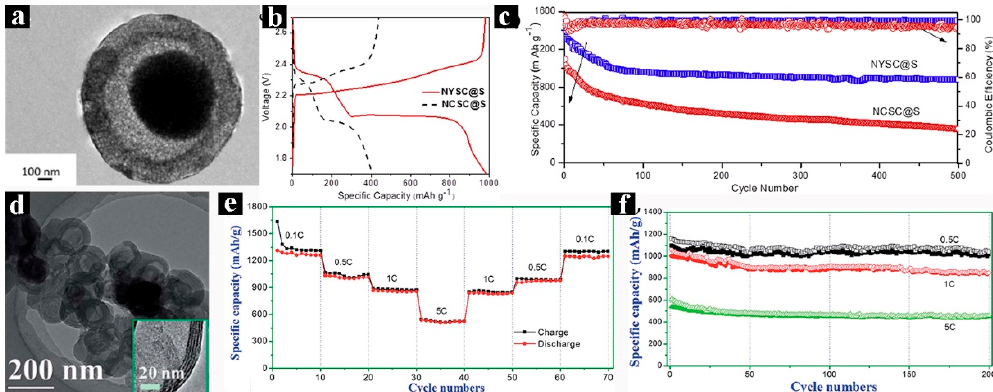
Figure 13. Transmission electron microscopy (TEM) images of yolk-shell and multi-shell spheres and their LSBs performance: ( a ) TEM image of the N-doped yolk-shelled carbon (NYSC), ( b ) galvanostatic charge and discharge profiles for 300th cycle, and ( c ) long cycling performance and Coulombic efficiency (CE) of the NYSC@S, NCSC@S electrodes at 0.2 C. ( d ) TEM image, ( e ) rate capability, and ( f ) cycling performance of multi-shelled hollow carbon spheres (MHCS) composites. Pictures ( a ), ( b ), and ( c ) were reprinted with permission from Reference [186]. Copyright Elsevier, 2018. Pictures ( d ), ( e ), and ( f ) were reprinted with permission from Reference [187]. Copyright the Royal Society Chemistry, 2014.